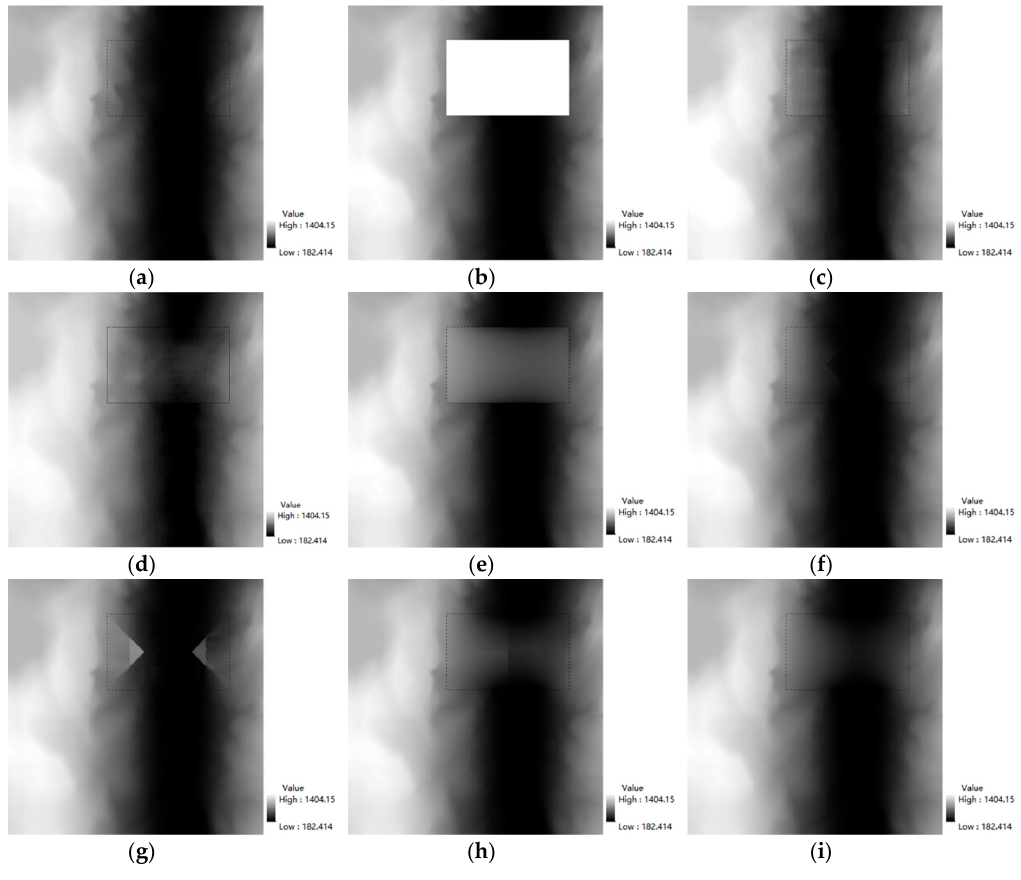
Figure 6. DEM filling results in Norway (complex terrain). ( a ) Raw DEM data; ( b ) DEM data with a void; ( c ) our method; ( d ) WGAN method; ( e ) IDW method; ( f ) RBF method; ( g ) EBK; ( h ) Rst; and ( i ) Bicubic.